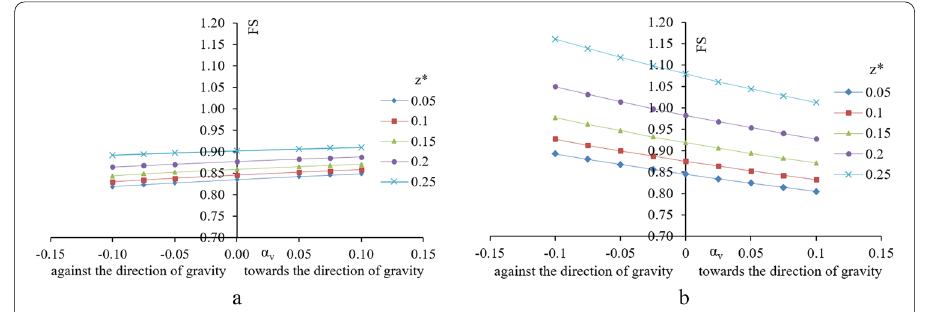
Fig 6. FS vs α v on different values of z *: a case 1and b case